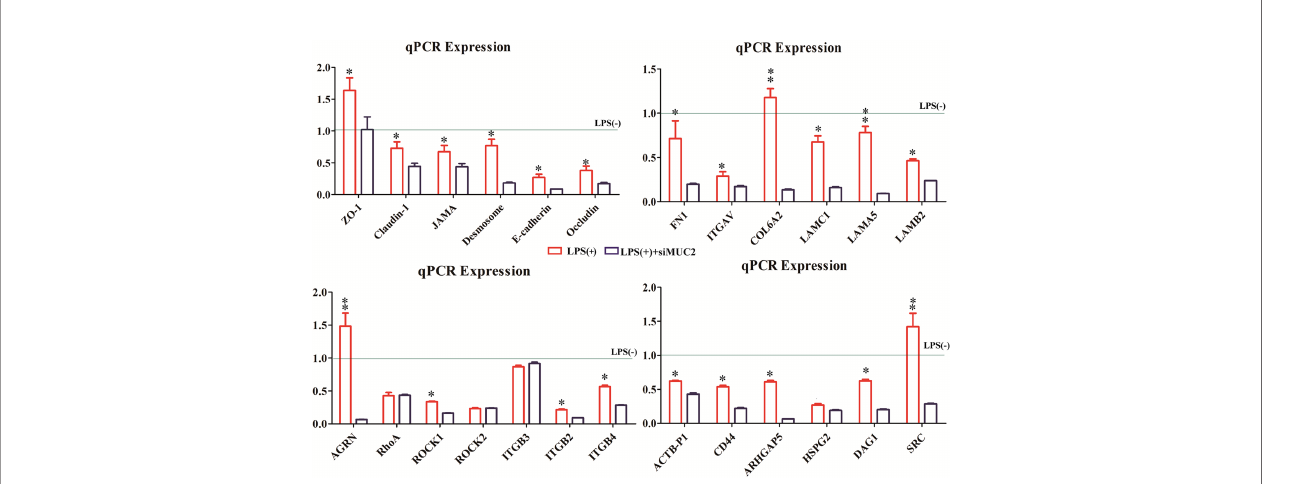
FIGURE 5 | The expression of different genes in the LPS(+), LPS(+)+siMUC2, and LPS(-) groups.Statistical analyses were performed using the Statistical Package for Social Sciences (SPSS, USA) software, and a two-pair test followed by Student ’ s t-test was performed to determine statistical signi fi cance between means (N=6). The relative expression levels of the target genes were calculated using the 2 - DD CT method. The factors mRNA expression of LPS(-) group are “ 1 ” (gray line).* Statistical difference between co-culture Caco2/HT-29 cells in the LPS(+) and LPS(+)+siMUC2 groups for the same factors ( P <0.05). ** Statistical difference between co-culture Caco2/HT-29 cells in the LPS(+) and LPS(+)+siMUC2 groups for the same factors ( P <